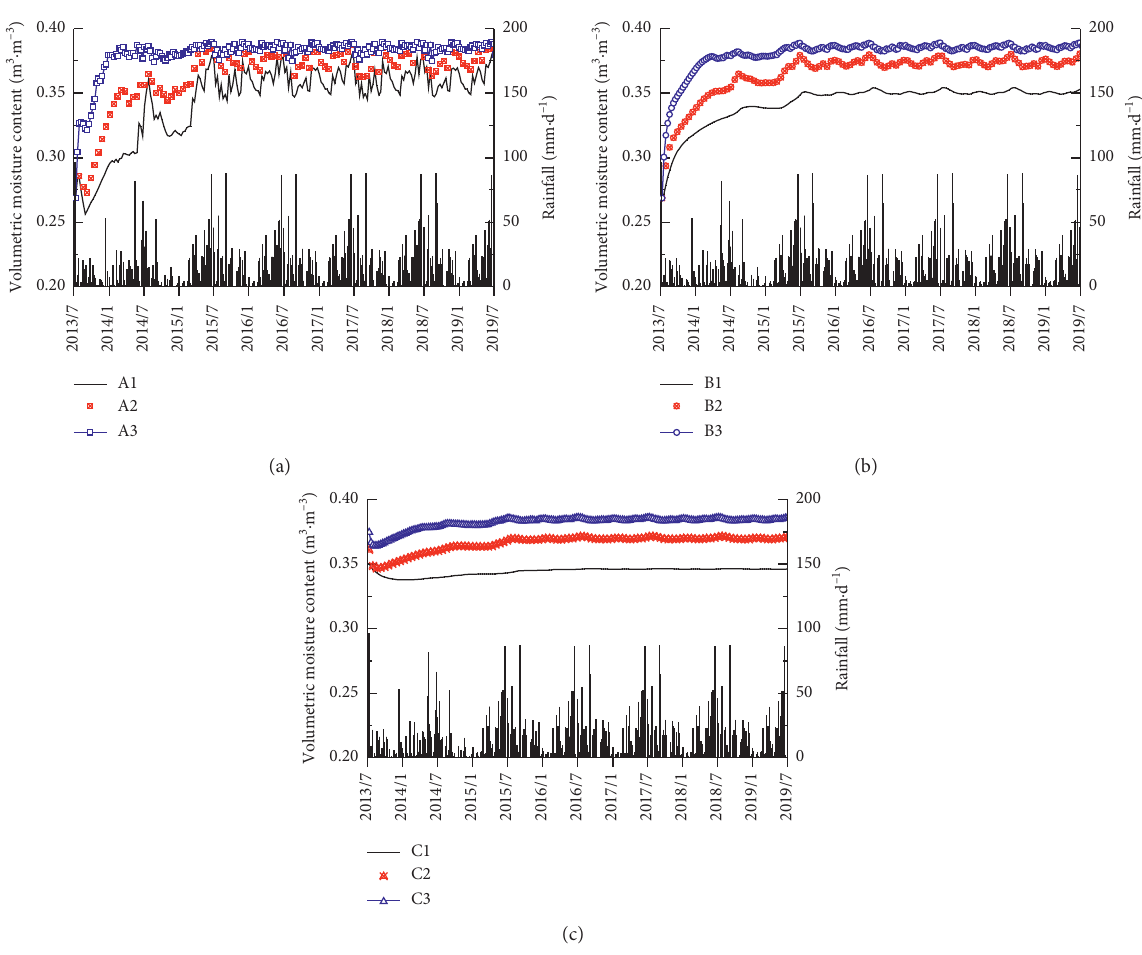
Figure 9: Volumetric moisture content overtime of 9 points: (a) A1 ∼ A3; (b) B1 ∼ B3; (c) C1 ∼